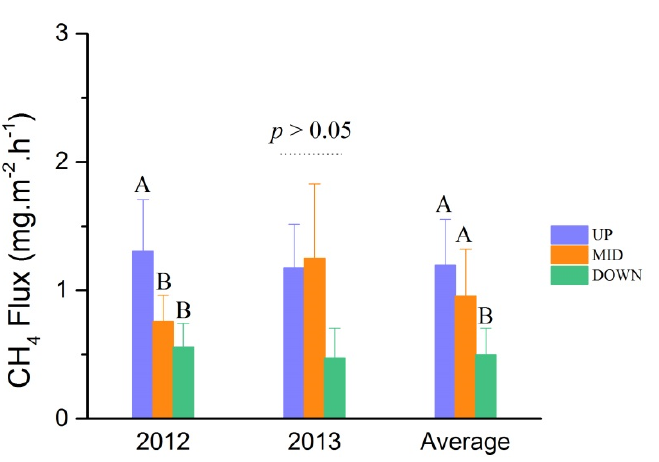
Figure 5. The average CH 4 fluxes of the three regions (LSD test, uppercase: p < 0.01).